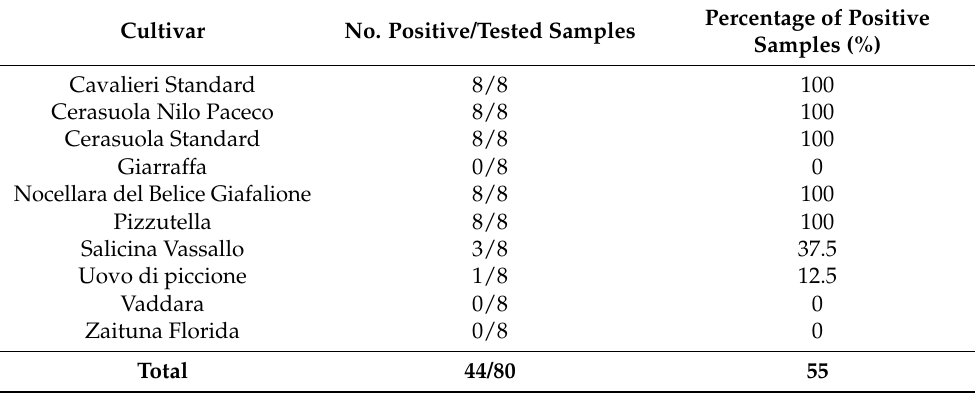
Table 1. Prevalence and cultivar distribution of OEGV analyzed by end-point